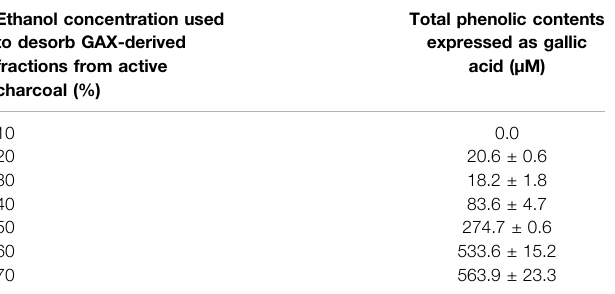
TABLE 3 | Phenolic contents in GAX-derived fractions from the extract that remained soluble in 90% (v/v) ethanol, as described in Table 2 . Soluble material was adsorbed in active charcoal and desorbed by increasing ethanol concentrations.